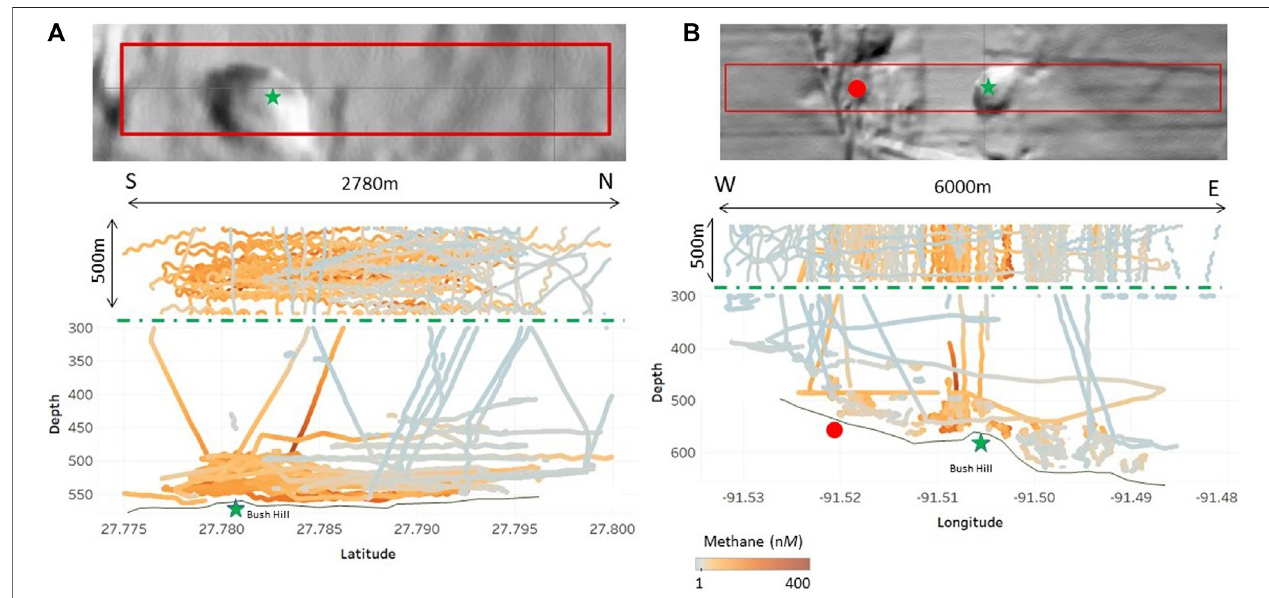
FIGURE 5 | Observed methane concentrations around Bush Hill during the spring study are depicted as color shading along the paths of the gliders. The upper imagesaredetailedgray-shadedbathymetricreliefmapsoftheareashowinglocationboxesfordatainmiddleandlowerimages.ThelocationofBushHillismarkedasa green star in each and the location of another potential methane source is noted as a red circle in the E-W shaded relief map (see Figure 1C for context). The middle images shows all glider data from 300 m down used to construct the vertical section smashed to a horizontal plane. The bottom images are S-N (A) and W-E (B) 500 m thick verticaldata smashes onto a plane. The projected glider paths ’ color indicate the methane concentration (see scale) with orange colors indicating con fi dent detections. The divergence of the methane scale is set at 10 × the environmental background.